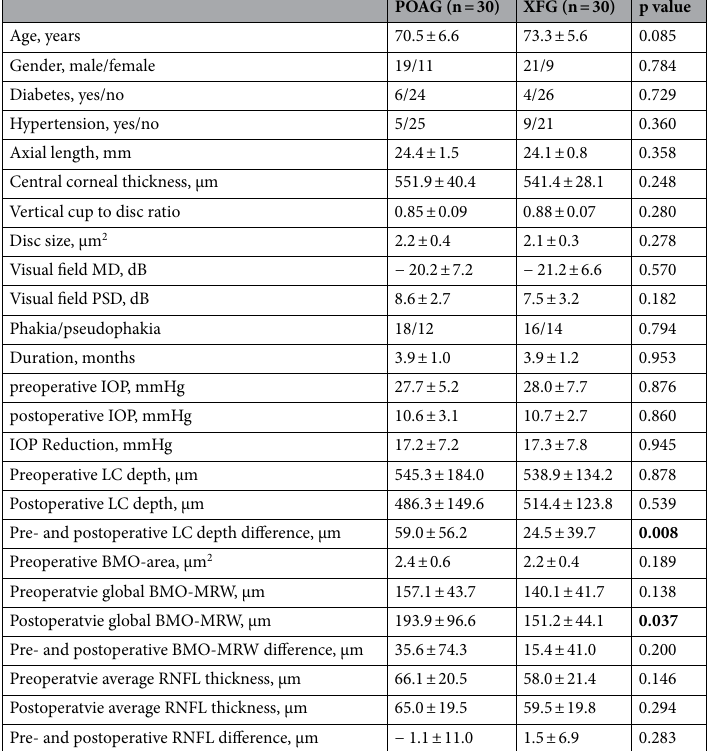
Table 1. Demographic and baseline characteristics of patients with primary open-angle glaucoma and exfoliation glaucoma. POAG primary open-angle glaucoma, XFG exfoliation glaucoma, MD mean deviation, PSD pattern standard deviation, dB decibel, IOP intraocular pressure, LC lamina cribrosa, BMO-MRW Bruch’s membrane opening-minimum rim width, RNFL retinal nerve fiber layer. Data are presented as mean ± standard deviation or n (frequency). Statistically significant p-values are shown in